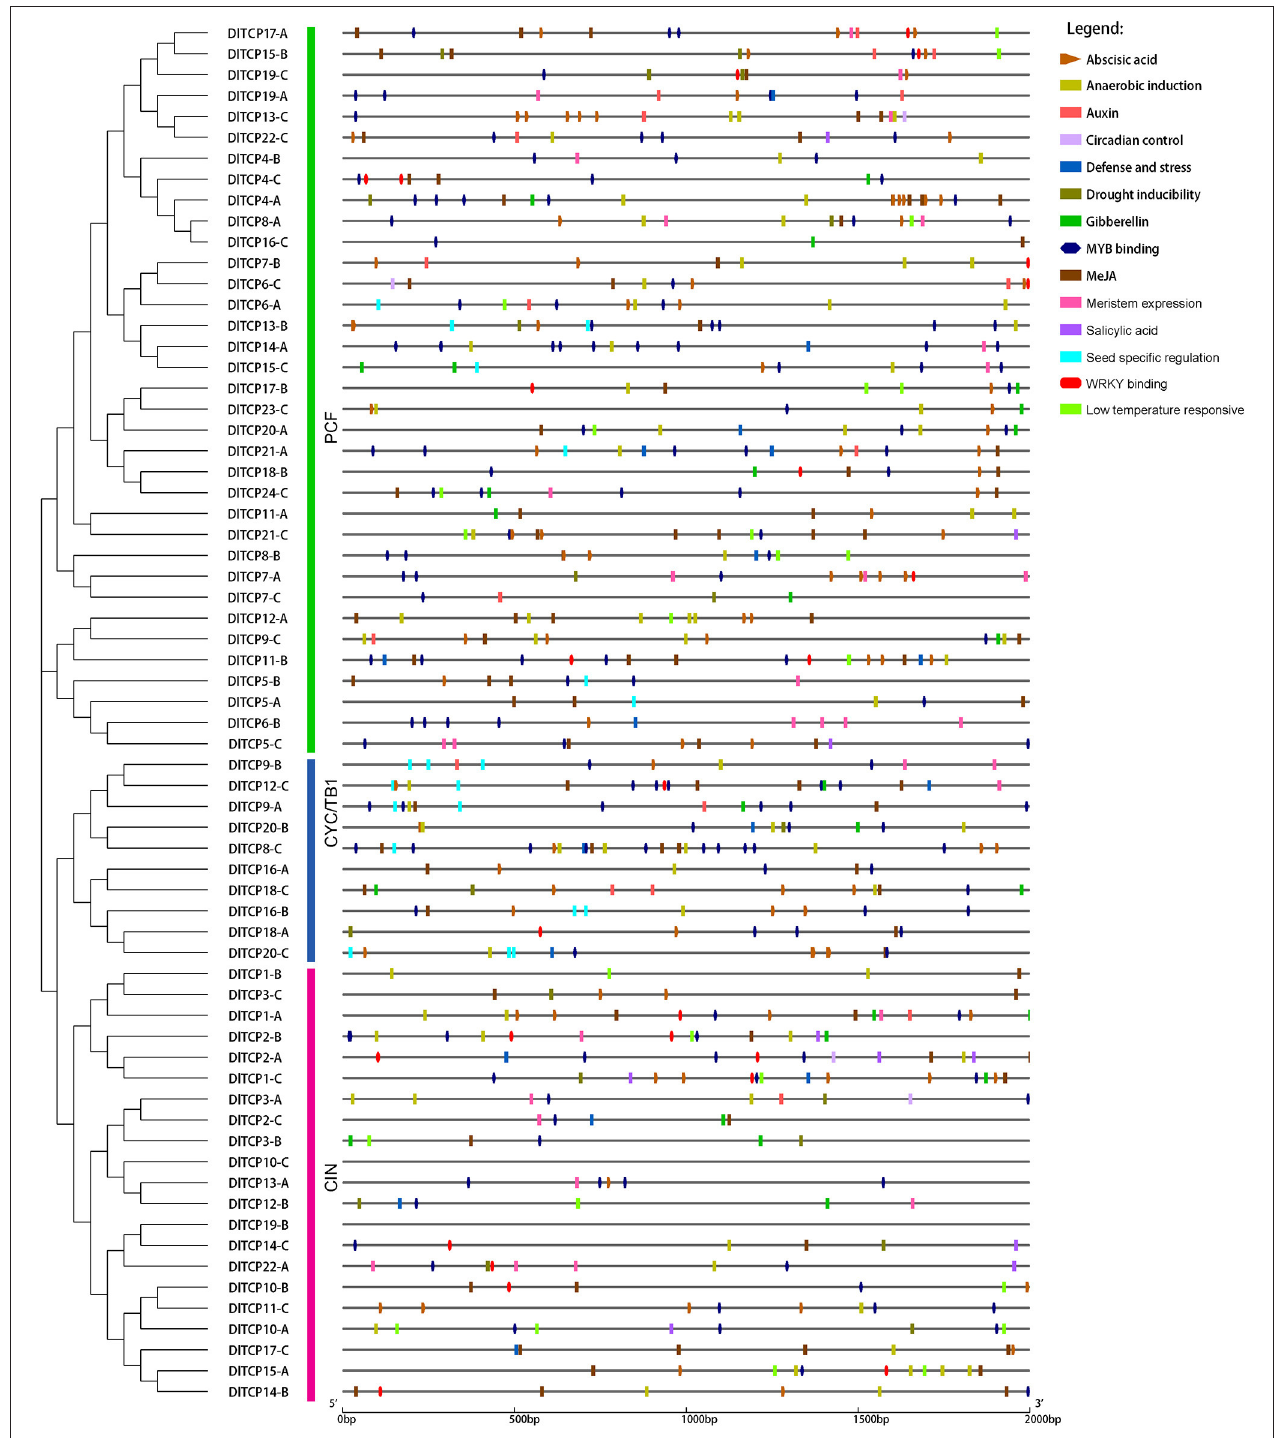
FIGURE 5 | Predicted cis-elements of TCP gene promoters in Ma bamboo. Plant CARE was used to predict and analyze the promoter region of the 2,000-bp upstream of 66 TCP members. Different colored rectangles represented different cis-elements and especial cis-elements were highlighted in different shapes. signals and further affect the development of axillary meristem, to adapt the plant architecture to environmental